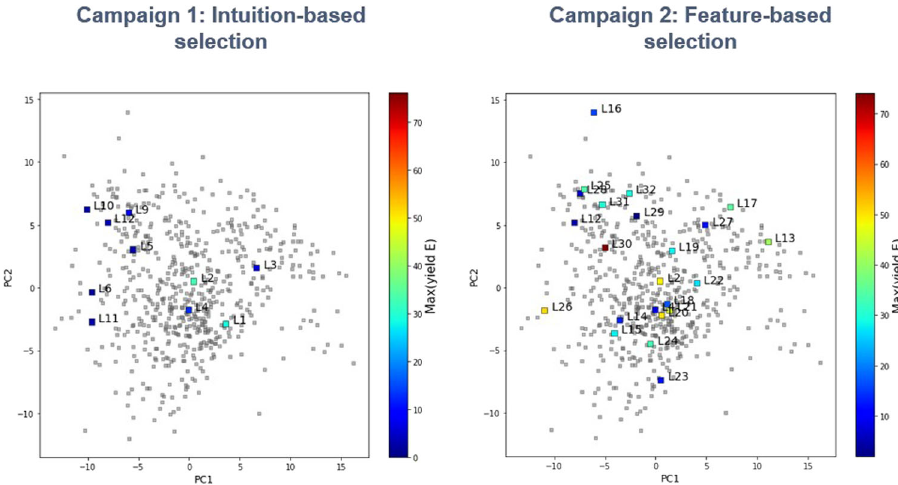
Fig. 9 The maximum yield of 2- E obtained for each monodentate ligand explored in campaigns 1 and 2 mapped onto the chemical space of 365 commercial monodentate phosphines. The chemical space is represented by a two-dimensional plot of the fi rst two principal components. Color indicates the maximum yield of 2- E obtained for each evaluated monodentate phosphine ligand.